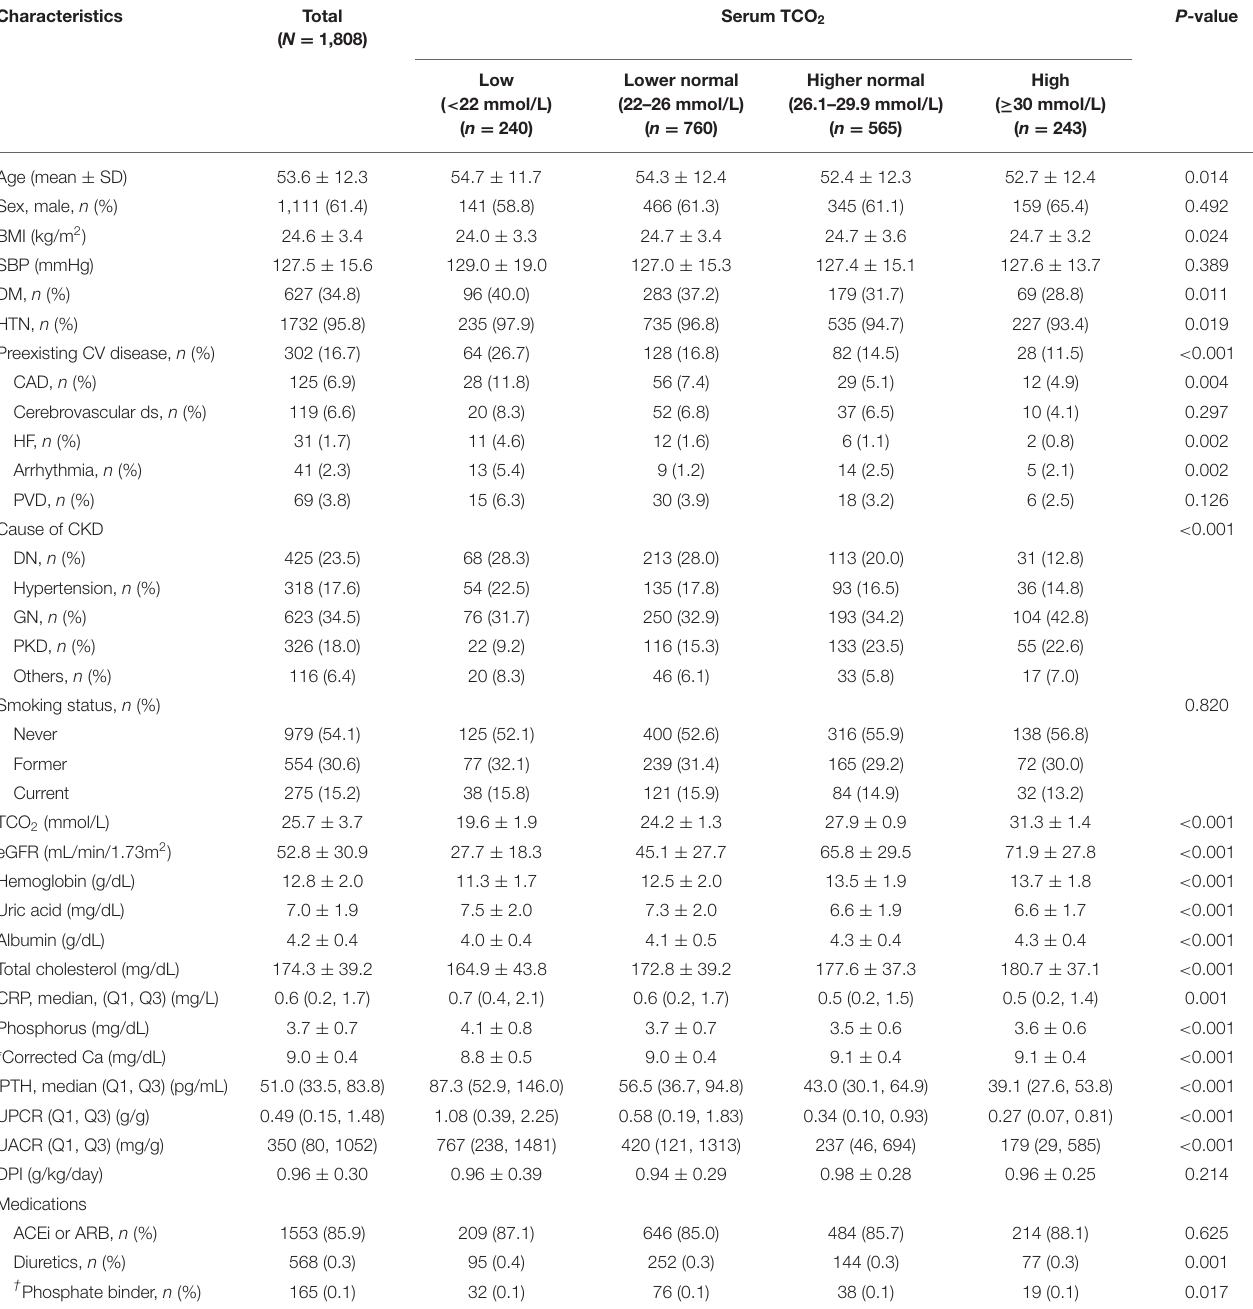
TABLE 1 | Clinical characteristics of the study subjects at enrollment, stratified by serum bicarbonate concentration.